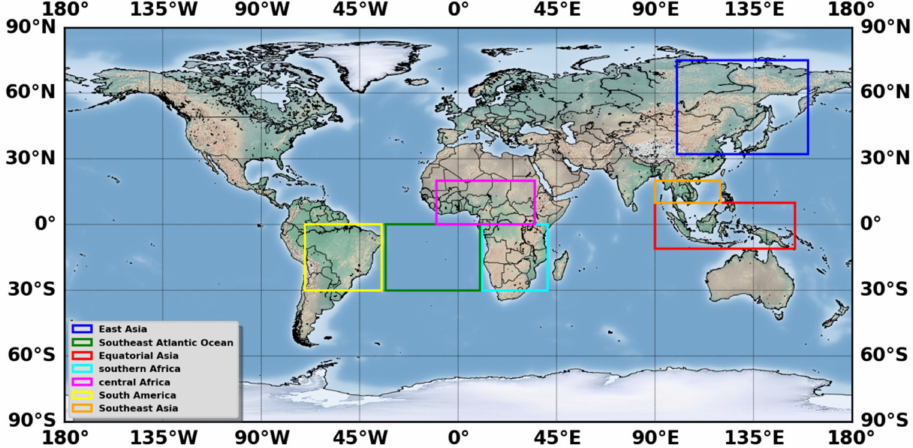
Figure 2. Geographical domains of the sub-regions considered for the regional